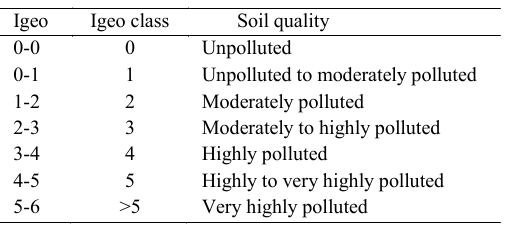
Table 1: Igeo classes in relation to soil quality (Serbaji et al., 2012) Igeo Igeo